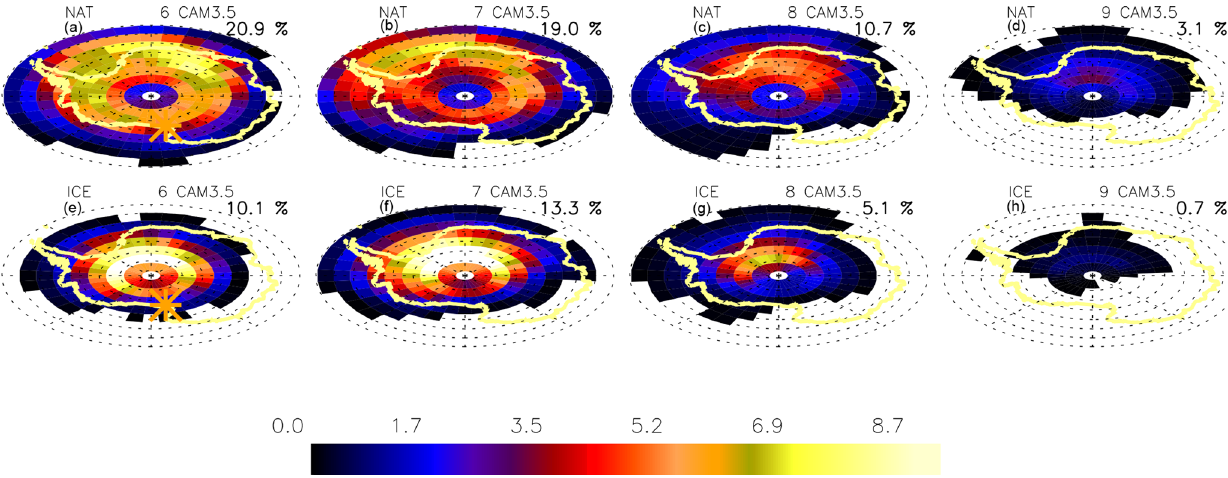
Figure 6. CAM3.5 PSCs vertical extent (in km) for NAT and ice, averaged over 5 years during the months of June, July, August and September (left to right). In the left column, the location of McMurdo is indicated with a yellow asterisk. The fraction of the overall air volume (between 12 and 30km height south of 60 ◦ S) occupied by different PSC classes for each month is reported in the top-right corner.